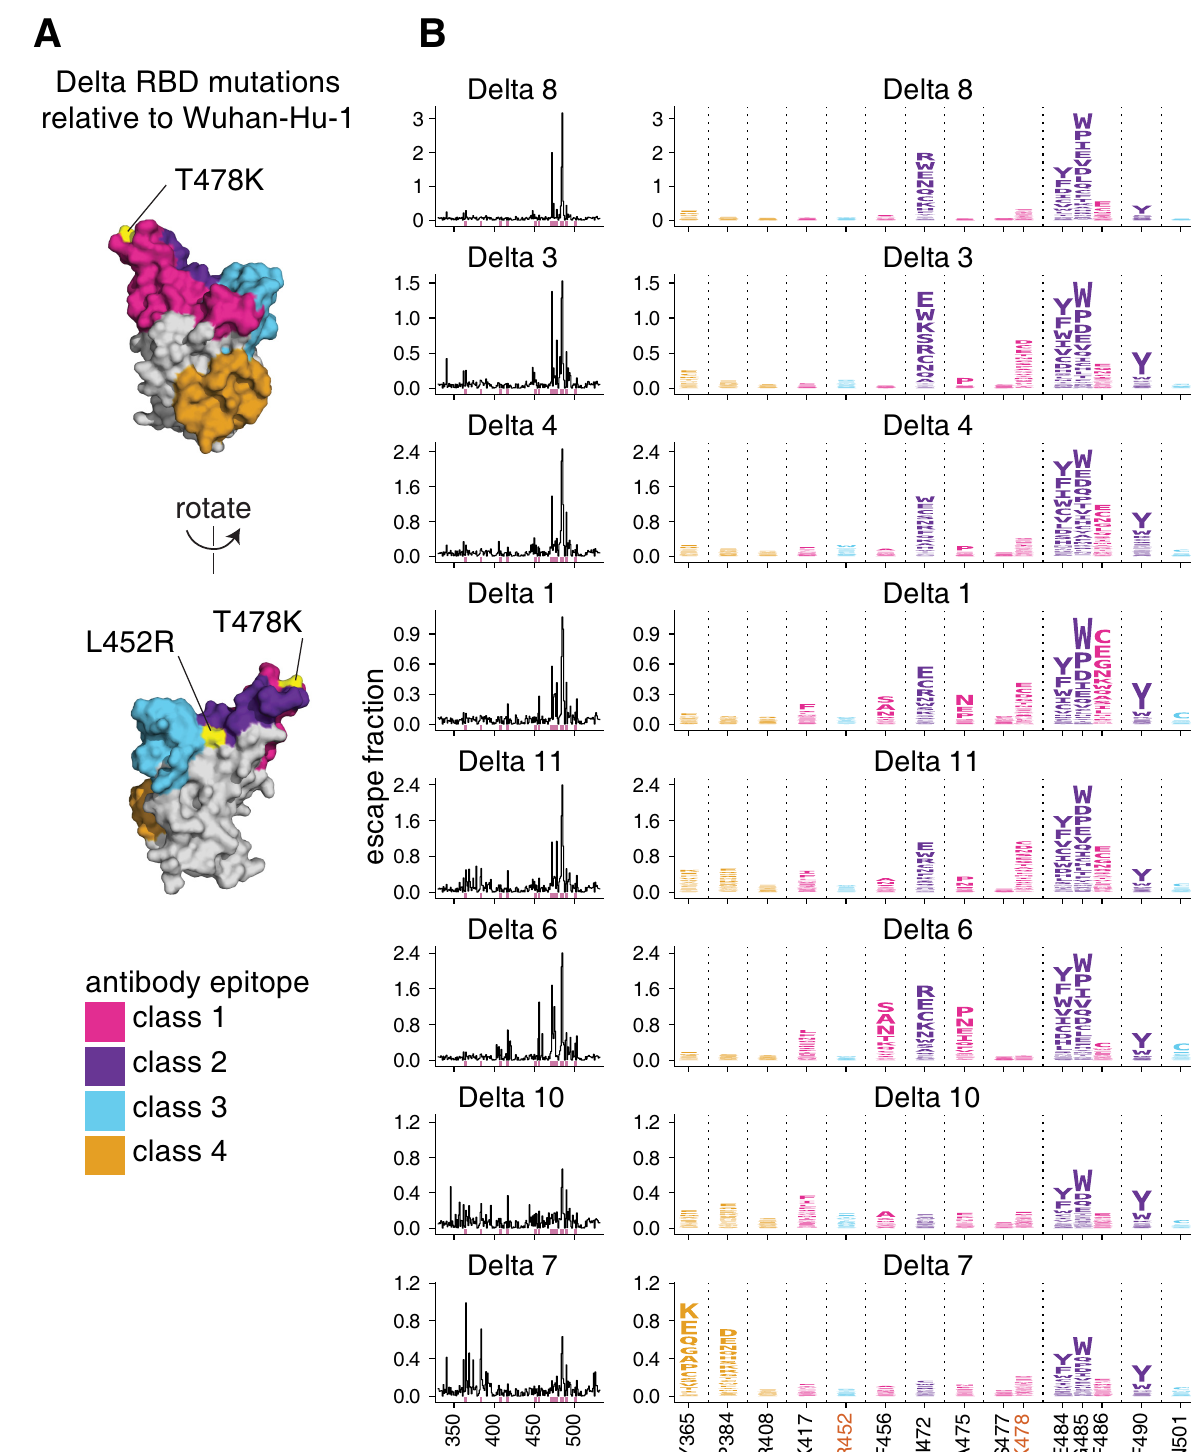
Fig 3. Complete antibody-escape maps for plasmas from individuals convalescent of primary Delta infections. (A) The surface of the Wuhan-Hu-1 RBD is colored according to antibody epitope per the Barnes classification scheme [37], with the L452R and T478K mutations in the Delta variant highlighted in yellow (and labeled with red text in panel B). We define L452R to be in the class 3 epitope, and T478K in the class 1 epitope.